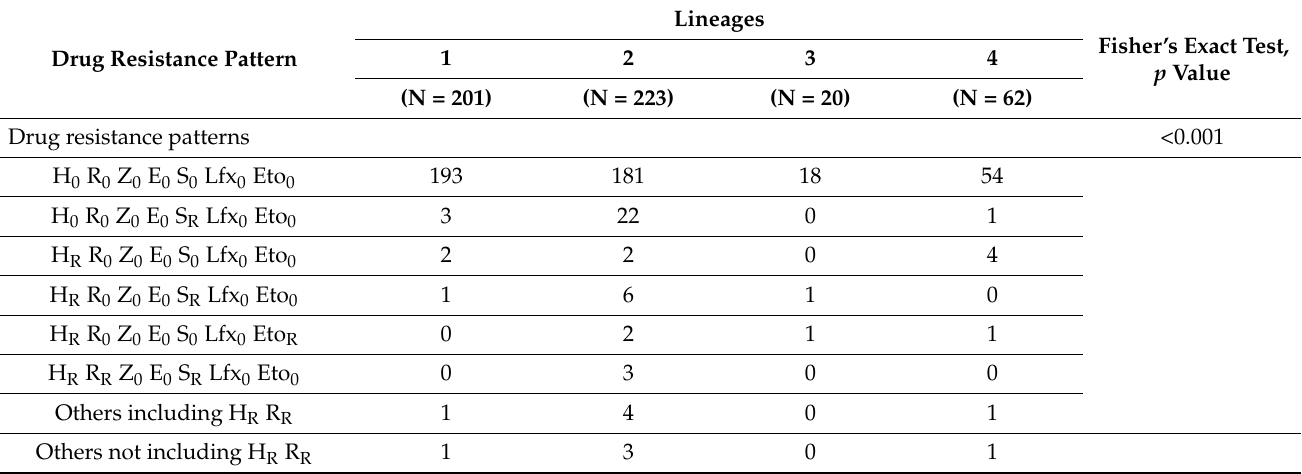
Table 5. Association between lineages and drug resistance pattern.